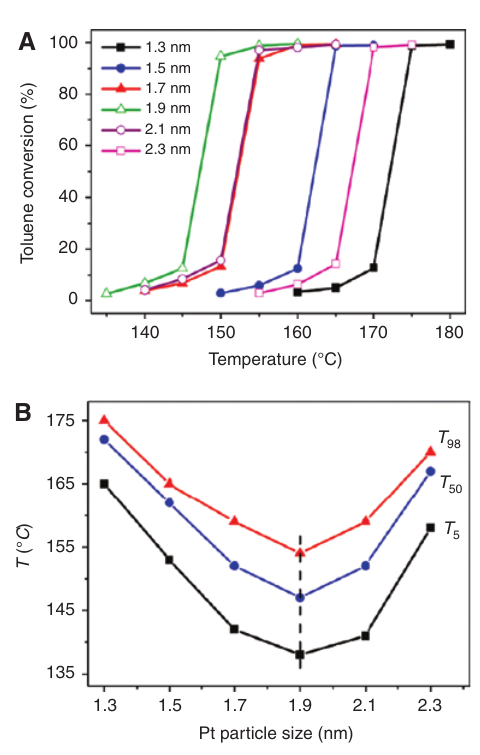
Figure 7: (A) Dependence of the catalytic activity on reaction temperature and (B) the dependence of T Pt particle size in the complete oxidation of toluene over the Pt- x / ZSM-5 catalysts. Reproduced from [30] with permission from the Royal Society of